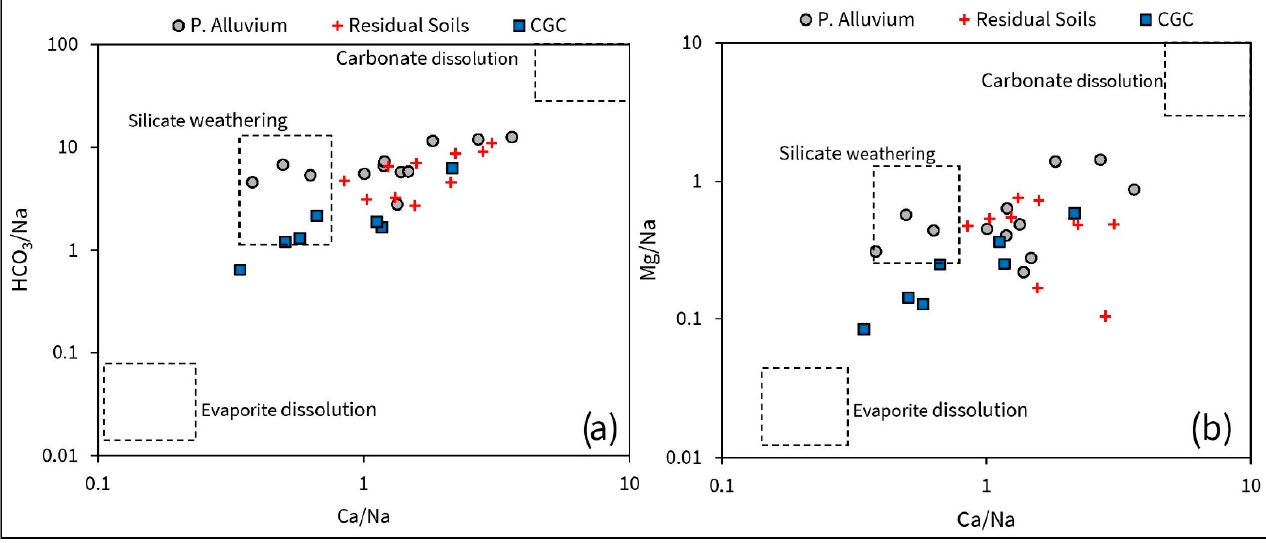
Figure 6. Bivariate molar ratio plots, ( a ) HCO 3 /Na vs. Ca/Na, ( b ) Mg/Na vs. Ca/Na. Na and K ions may be removed from the solution by reverse cation exchange process, while Ca may be removed from the solution by cation exchange process (Equation (4)) with clay minerals as indicated by Chloroalkaline Index (CAI) vs. TDS graph (Figure 8). The CAI is calculated using the formula: CAI = [Cl − − (Na + + K + )]/Cl − . A positive CAI indicates a reverse cation exchange process (Equation (4) would proceed toward the left), while a negative CAI indicates a forward cation exchange process (Equation (4) would proceed towards the right) [71]. A bivariate plot of (Ca 2+ + Mg 2+ − HCO 3 − − SO 42 − ) vs. (Na + − Cl − ) (Figure 9) can also be utilized to understand ion exchange processes